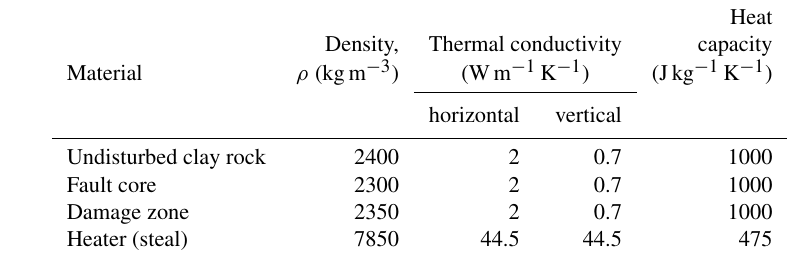
Table 2. Material properties used in the numerical simulations.